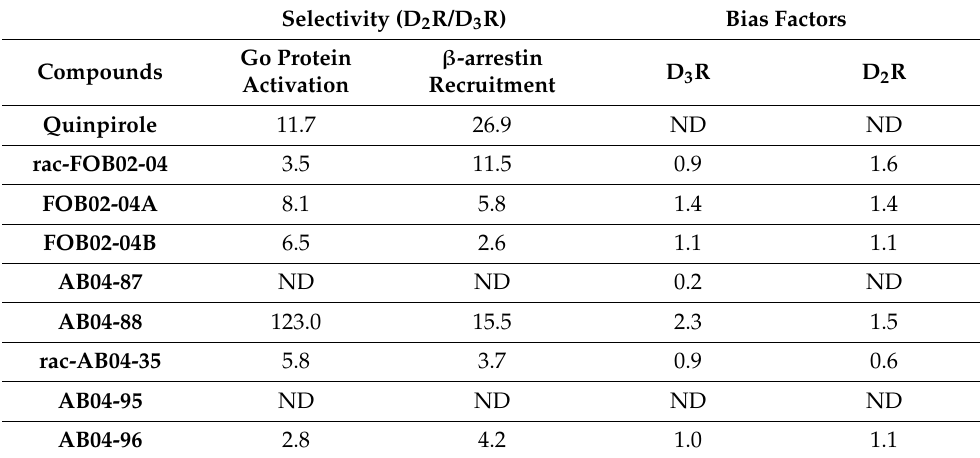
Table 3. D3R over D2R selectivity and Go protein vs. β -arrestin bias factors of bitopic